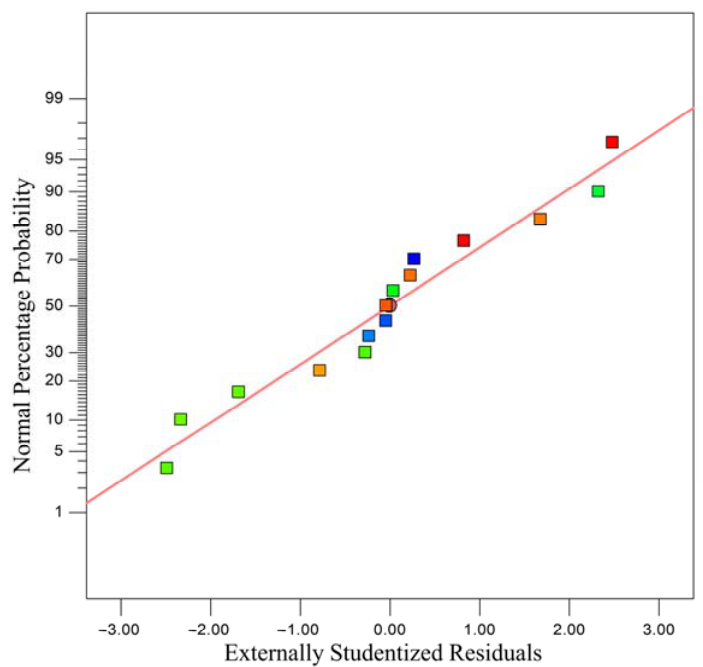
Figure 15. Residual normal probability map.